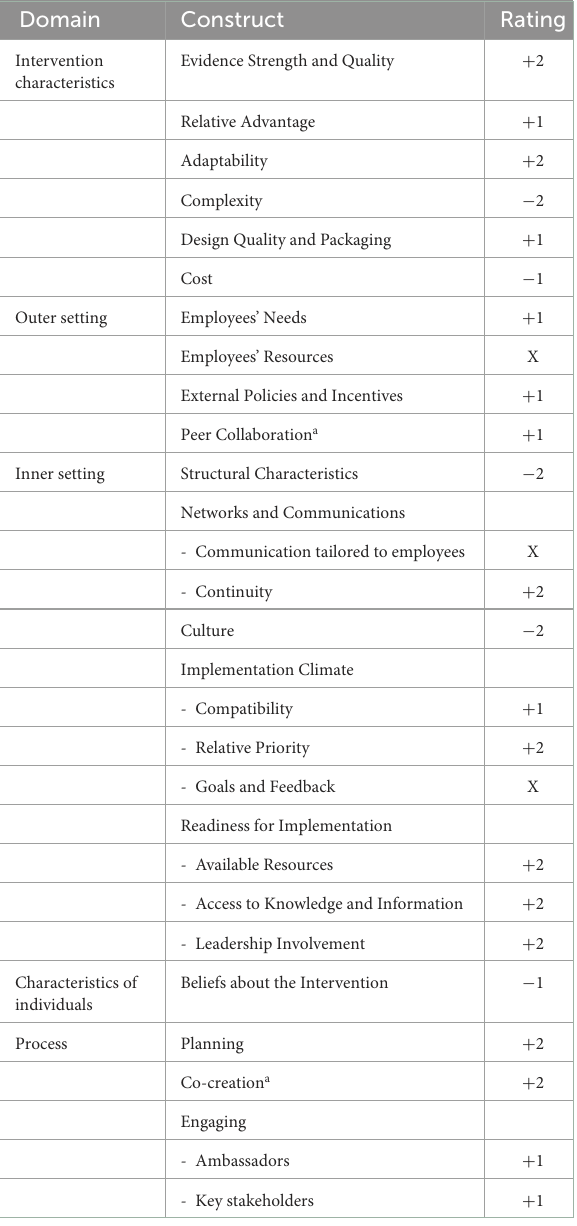
TABLE 3 Barriers and facilitators to the implementation of a